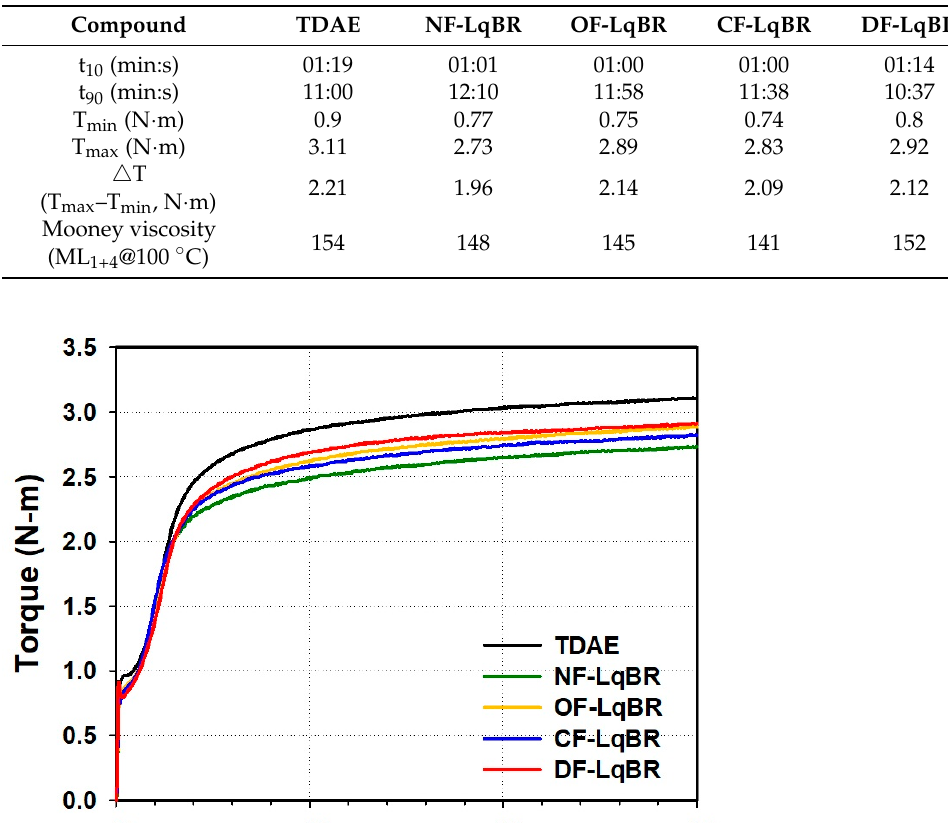
Table 7. Cure characteristics and Mooney viscosity of the compounds.